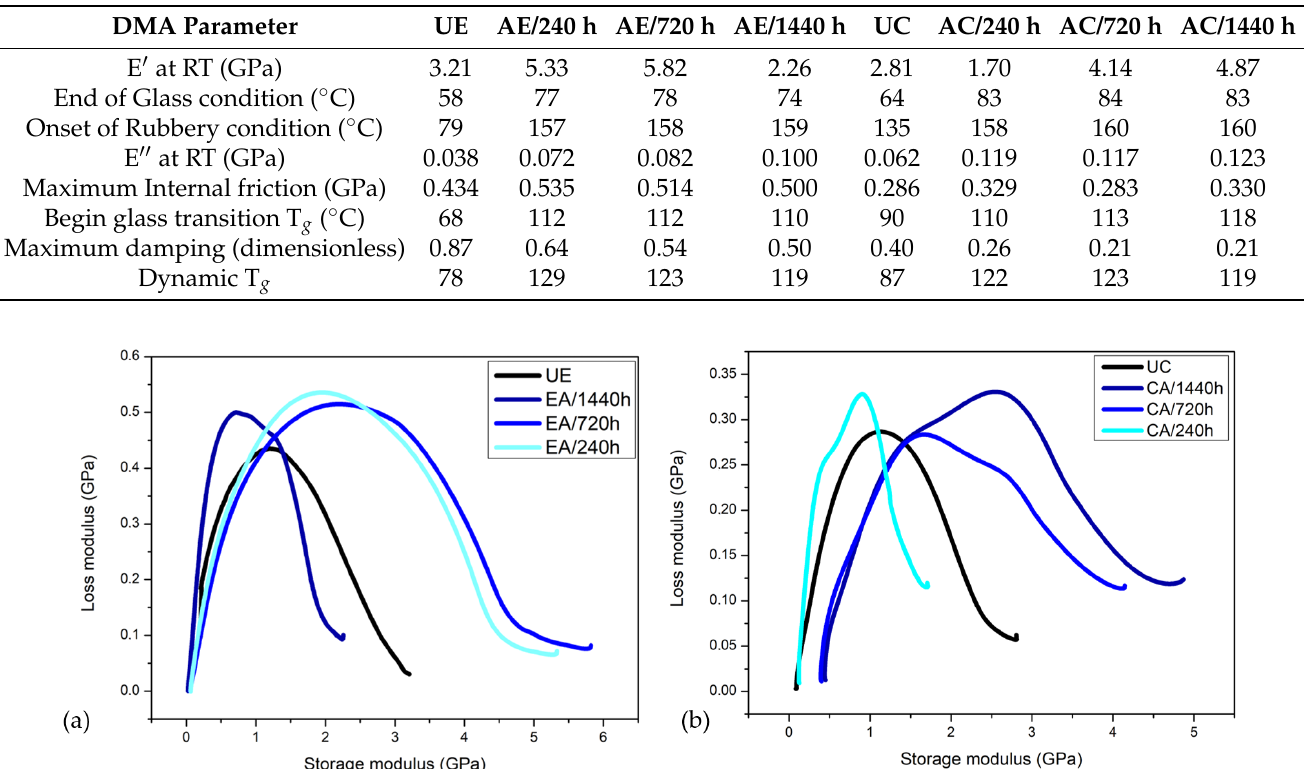
Table 3. DMA parameters for epoxy resin and its composites with 40 vol% fique fabric of both unaged and aged-by-water immersion.